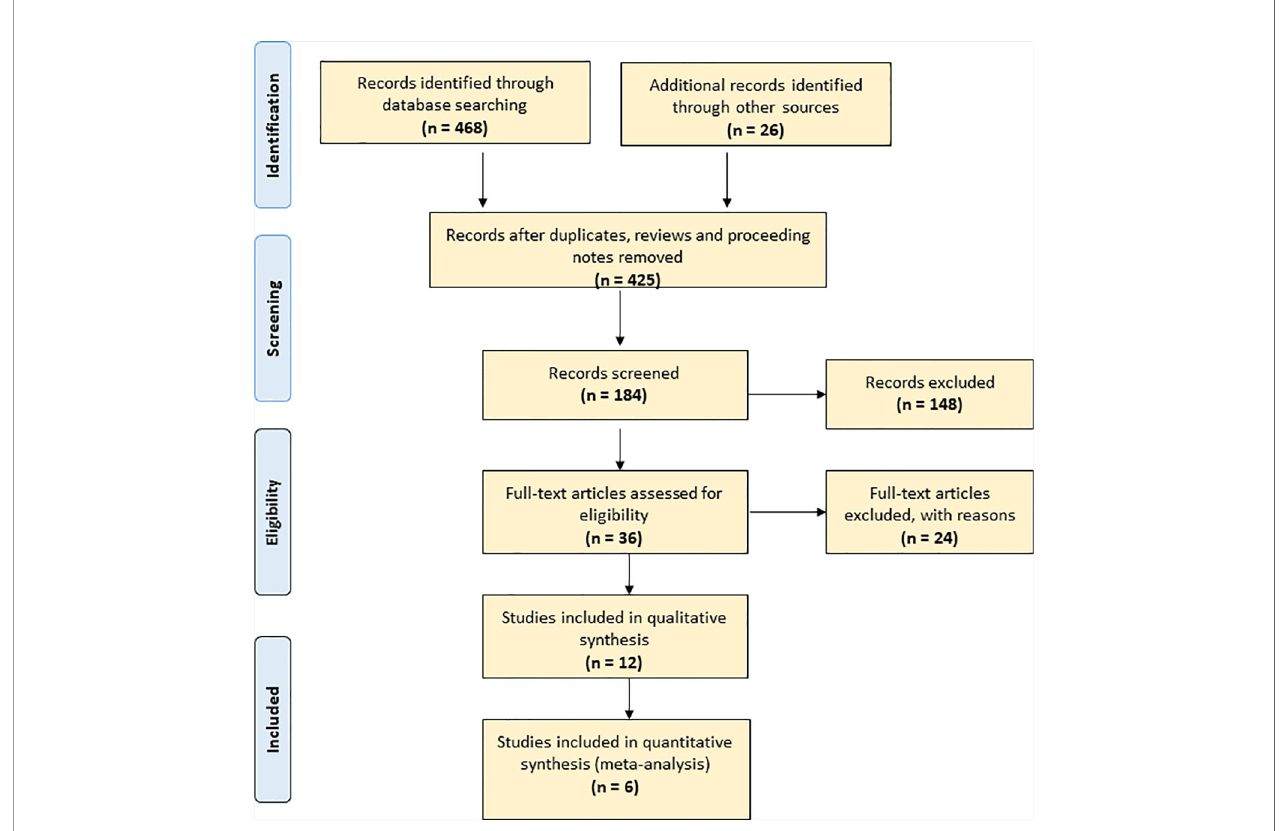
FIGURE 1 | PRISMA fl ow diagram of the current